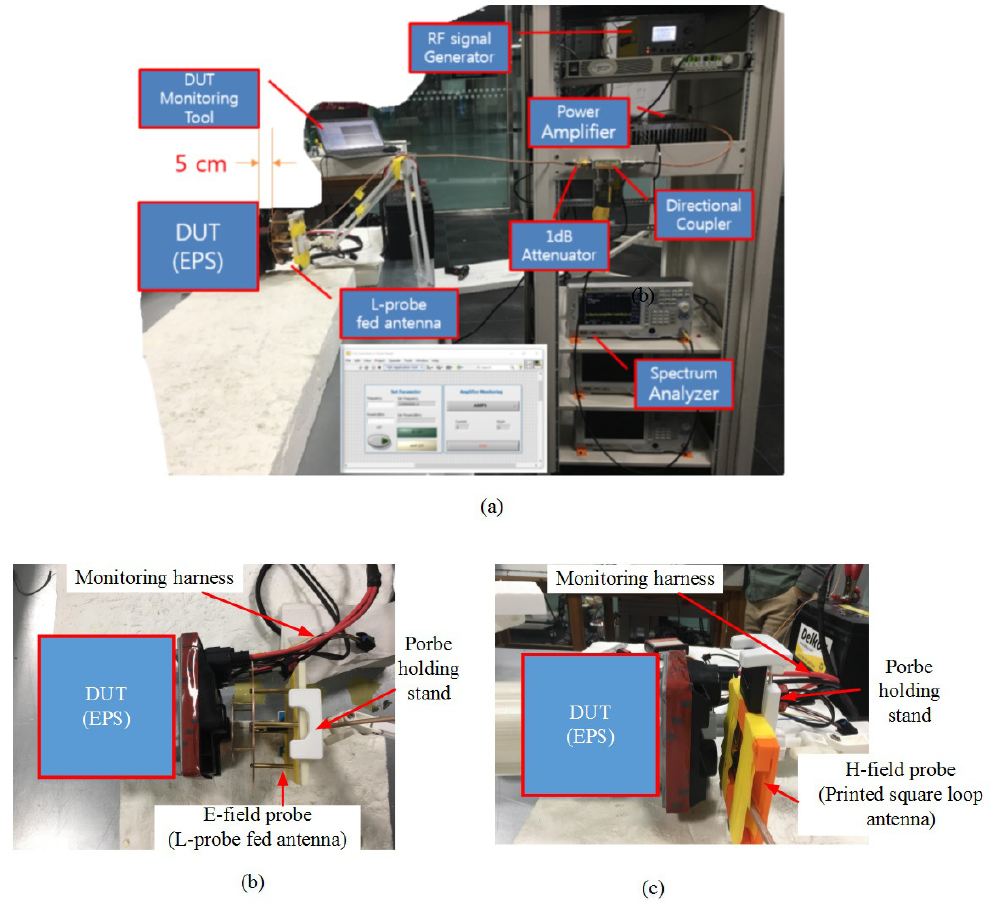
Figure 16. NFIT setup for the RI debugging of a specific automotive industry electronic DUT (EPS) ( a ) Complete laboratory bench test description of the proposed NFIT RI setup; ( b ) Photograph of the E-field probe and DUT (probe is 50 mm away from DUT); and ( c ) Photograph of the H-field probe and DUT (probe is 50 mm away from